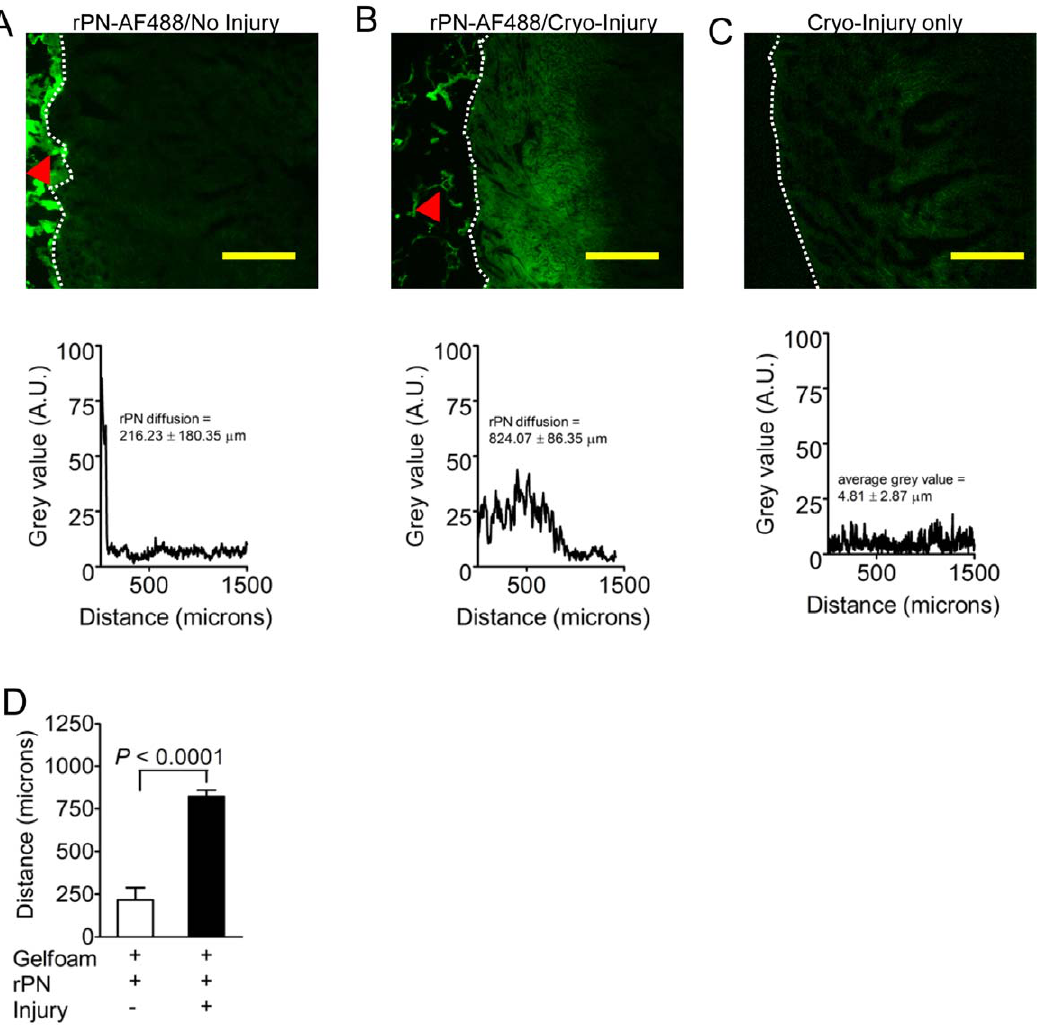
Figure 3. rPN readily diffuses into damaged myocardium. (A–B) Cross-sectional photomicrographs and pixel intensity profiles of rPN-AF488 diffusion through non-infarcted (A) and infarcted (B) mouse hearts. (C) Photomicrograph and pixel intensity prolife for cryo-injured heart only. (D) Quantification reveals that rPN readily diffuses through injured myocardium but not healthy intact muscle. Red arrows demarcate the epicardial surface and white arrows represent Gelfoam loaded with rPN-AF488. Analysis was performed 2 hrs after cryo-injury. The mean 6 SEM of 6 independent pixel intensity profiles is provided in the graphs.